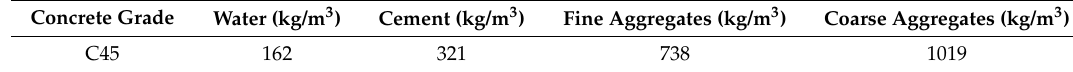
Table 1. Mix proportion of